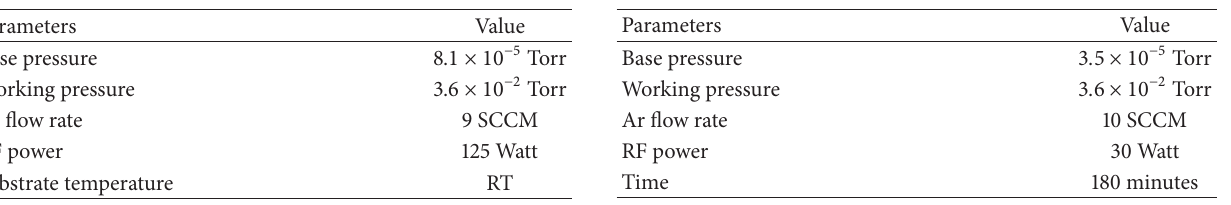
Table 1: Parameters of Mo sputtering. Table 2: Parameters of CZTS